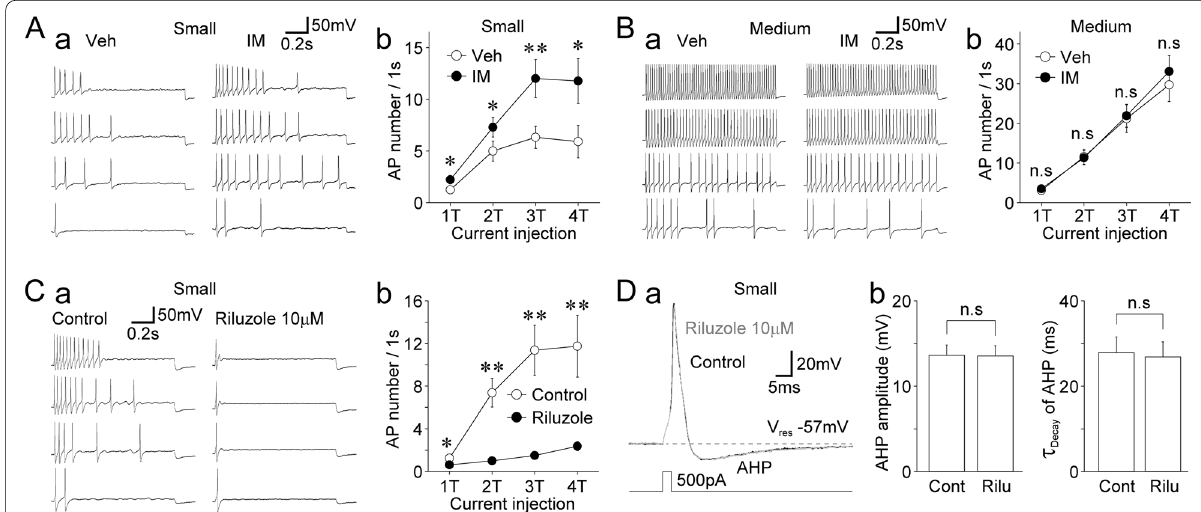
Fig. 8 Inflammatory mediator‑induced changes in the excitability of small‑sized dural afferent neurons. A. a , Typical voltage traces in response to depolarizing current injections in vehicle‑treated (left) and IM‑treated (right) small‑sized DiI‑positive neurons. Four representative raw traces were elicited by one‑fold threshold (1 T; 150 pA) to four‑fold threshold depolarizing current injections. b , Changes in the number of action potentials elicited by depolarizing current injections (1 T–4 T) in vehicle‑treated (open circles) and IM‑treated (closed circles) small‑sized DiI‑positive neurons. The points and error bars represent the mean and SEM from 12 vehicle‑treated and 13 IM‑treated small‑sized DiI‑positive neurons. *; p < 0.05, **; p < 0.01 (unpaired t‑test). B. a , Typical voltage traces in response to depolarizing current injections in vehicle‑treated (left) and IM‑treated (right) medium‑sized DiI‑positive neurons. Four representative raw traces were elicited by one‑fold threshold (1 T; 100 pA) to four‑fold threshold depolarizing current injections. b , Changes in the number of action potentials elicited by depolarizing current injections (1 T–4 T) in vehicle‑treated (open circles) and IM‑treated (closed circles) medium‑sized DiI‑positive neurons. The points and error bars represent the mean and SEM from 10 vehicle‑treated and 12 IM‑treated medium‑sized DiI‑positive neurons. n.s; not significant (unpaired t‑test). C. a , Typical voltage traces in response to depolarizing current injections in IM‑treated small‑sized DiI‑positive neurons in the absence (left) and presence (right) of 10 μM riluzole. Four representative raw traces were elicited by one‑fold threshold (1 T; 120 pA) to four‑fold threshold depolarizing current injections. b , Changes in the number of action potentials elicited by depolarizing current injections (1 T–4 T) in IM‑treated small‑sized DiI‑positive neurons in the absence (left) and presence (right) of 10 μM riluzole. The points and error bars represent the mean and SEM from eight IM‑treated small‑sized DiI‑positive neurons. *; p < 0.05, **; p < 0.01 (paired t‑test). D. a , Typical action potentials elicited by brief depolarizing current injections (3 ms duration, 500 pA) in the absence (black) and presence (gray) of 10 μM riluzole in medium‑sized DiI‑positive neurons. Note that riluzole (10 μM) did not affect afterhyperpolarization (AHP) of action potentials. b , Riluzole (10 μM)‑induced changes in the amplitude of AHP (left) and decay time constant of AHP (right) in IM‑treated small‑sized DiI‑positive neurons. The columns and error bars represent the mean and SEM from six IM‑treated small‑sized DiI‑positive neurons. n.s; not significant (paired